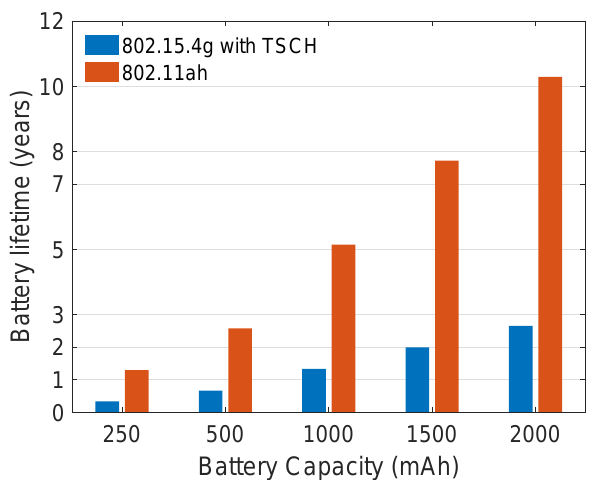
Figure 5. Battery lifetime of a device (both radio and microcontroller) transmitting once every 10 min for mid-range technologies (>1 km).